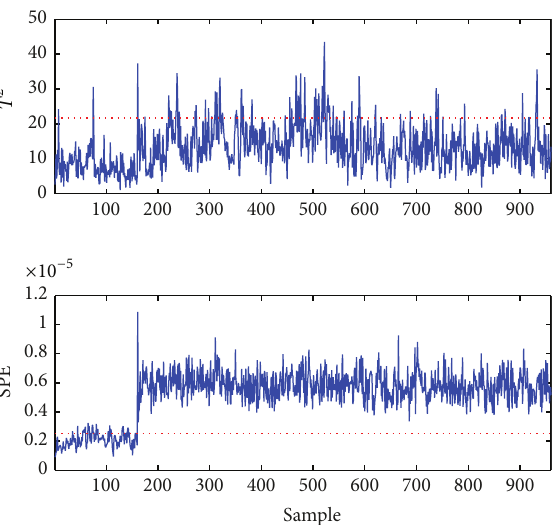
Figure 5: The PCA statistics for fault detection for fault 1.